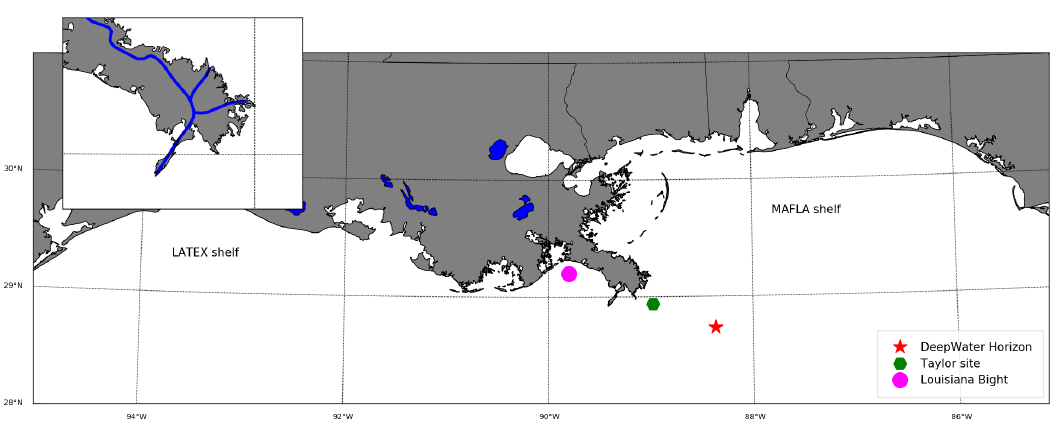
Figure 1. Map of the Northern Gulf of Mexico showing the geographical locations mentioned in the text. The map insert shows the Mississippi River (MR) delta in blue with the three major river passes that release MR water into the